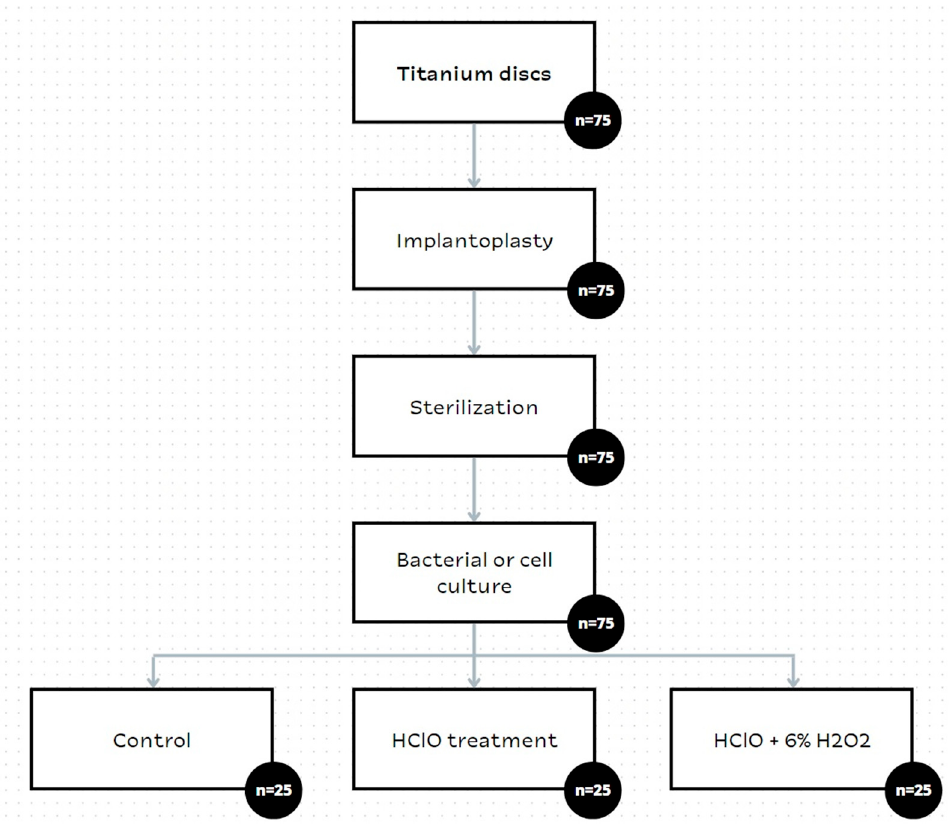
Figure 3. Scheme of the research of this study. The number represents to the total number of studied discs.